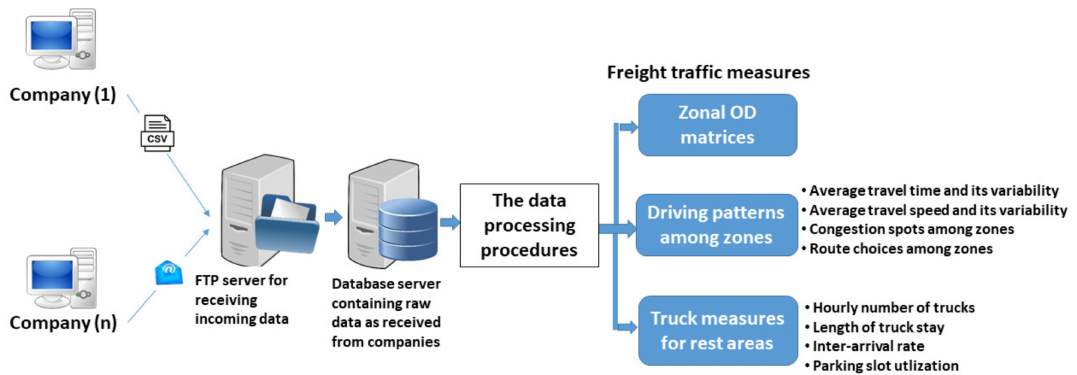
Figure 7. Overall structure of the developed data processing